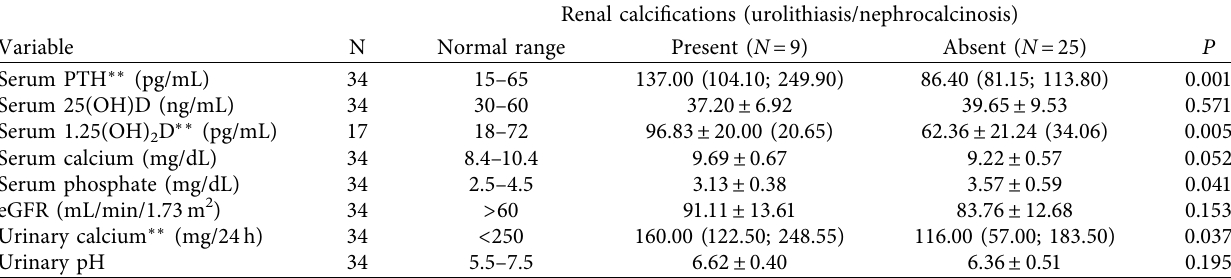
Table 2: Laboratory data in NPHPT patients with and without renal calcifications.